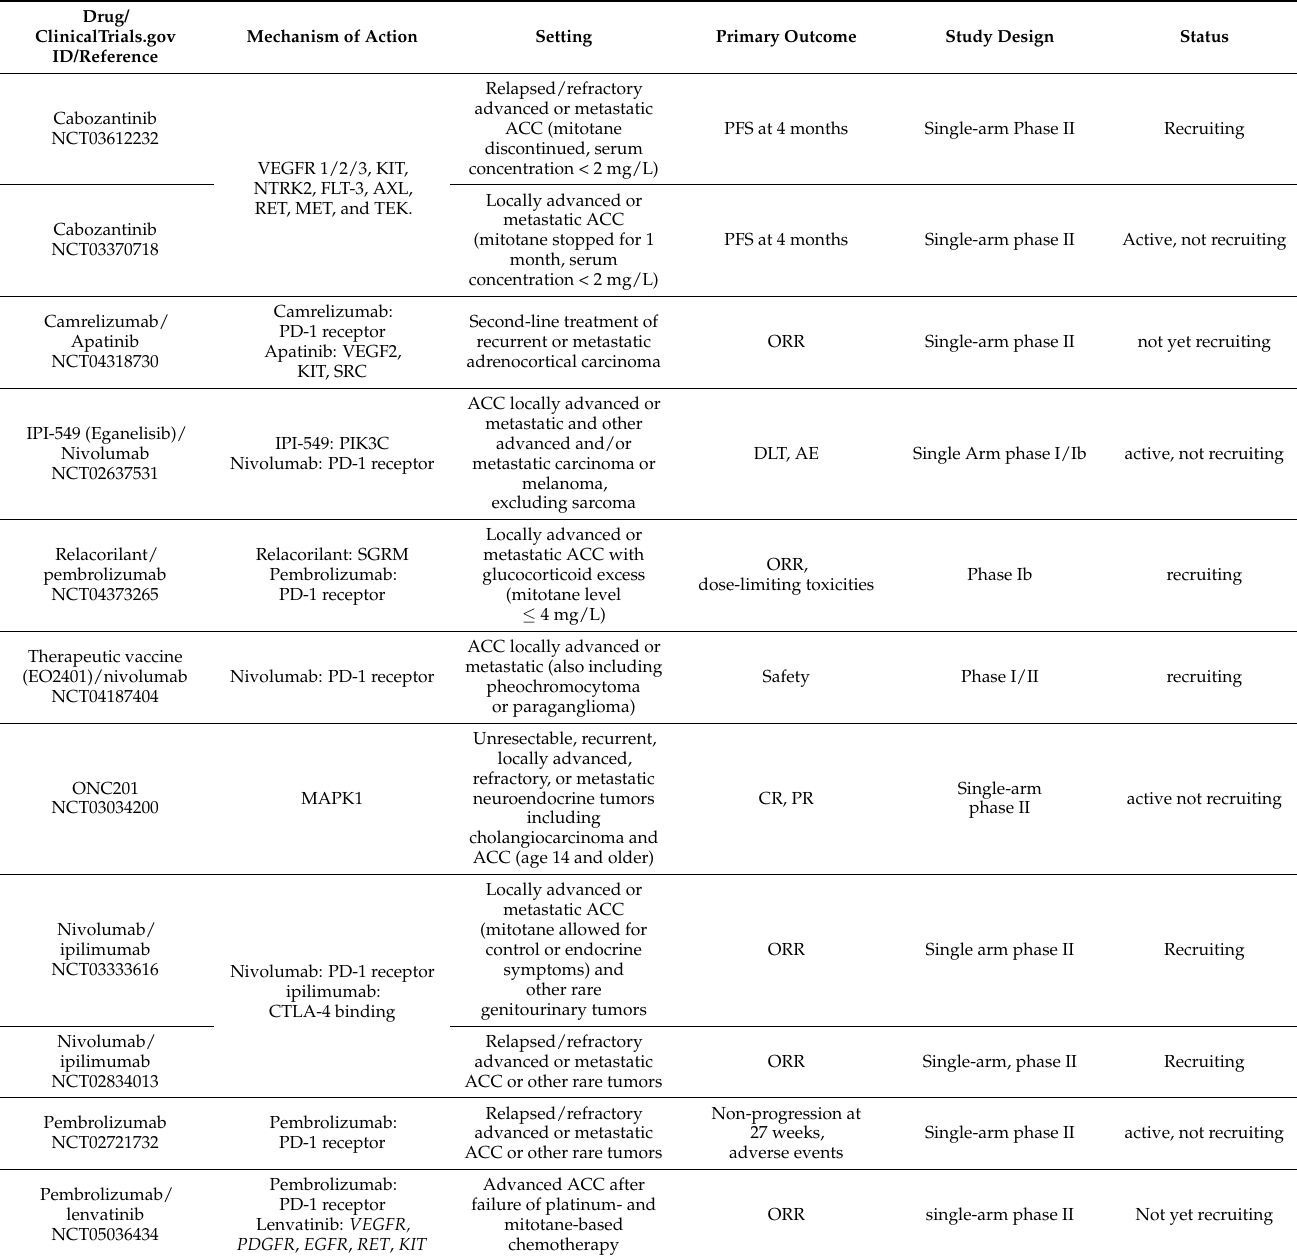
Table 1. Studies on ACC adapted from Kiesewetter et al.